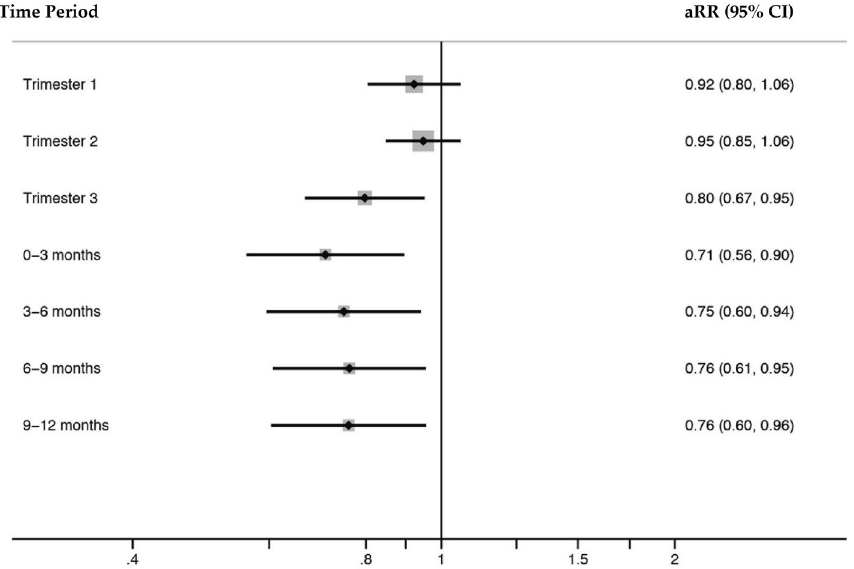
Figure 1. Forest plot of adjusted* relative risk (RR) for type 1 diabetes among boys born in Western Australia per 100 kJ m −2 increase in total ambient erythemal UVR